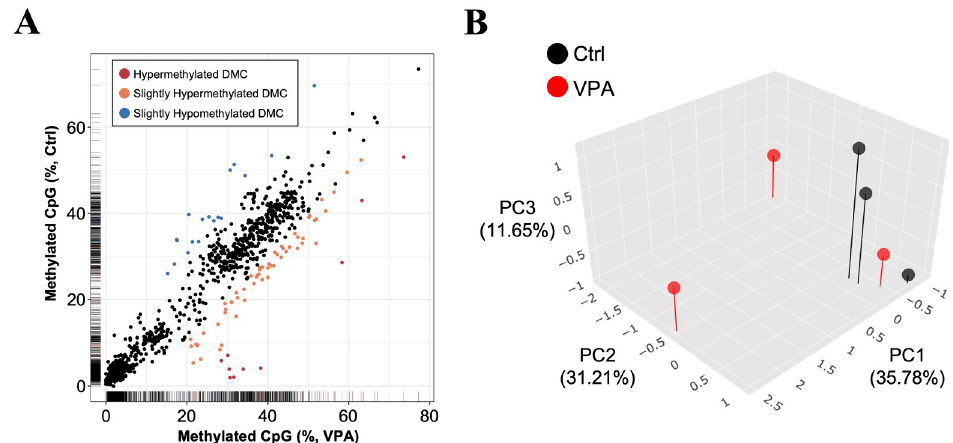
Fig 3. Morula DNA methylation analysis using whole-genome bisulfite sequencing. (A) Comparison of CpG methylation levels in morula derived from sperm of control and VPA-treated groups. Only CpGs with sequencing reads common to all samples are shown (1109 CpGs in total). The average methylation levels are indicated. CpGs with > 20% hypermethylation compared with that of the control group are shown in red, those with > 10% hypermethylation in orange, and those with > 10% hypomethylation in blue. (B) Principal component analysis (PCA) using methylation reads distribution for each sample.